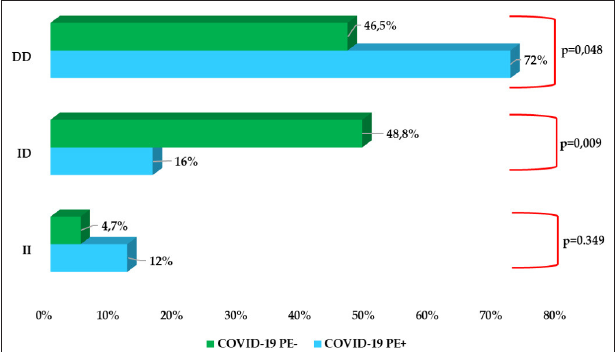
FIGURE 1 | Prevalence of ACE I/D polymorphism rs1799752 in COVID-19 PE + subgroup vs COVID-19 PE − subgroup.